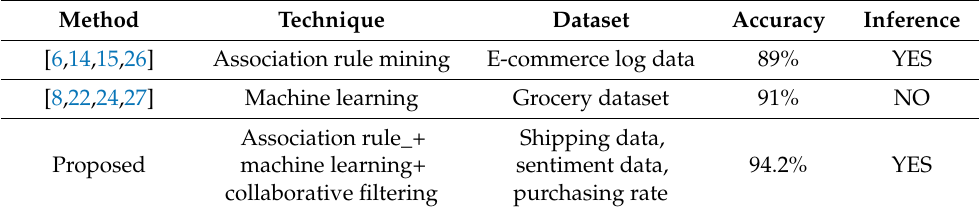
Table 2. Comparison with existing